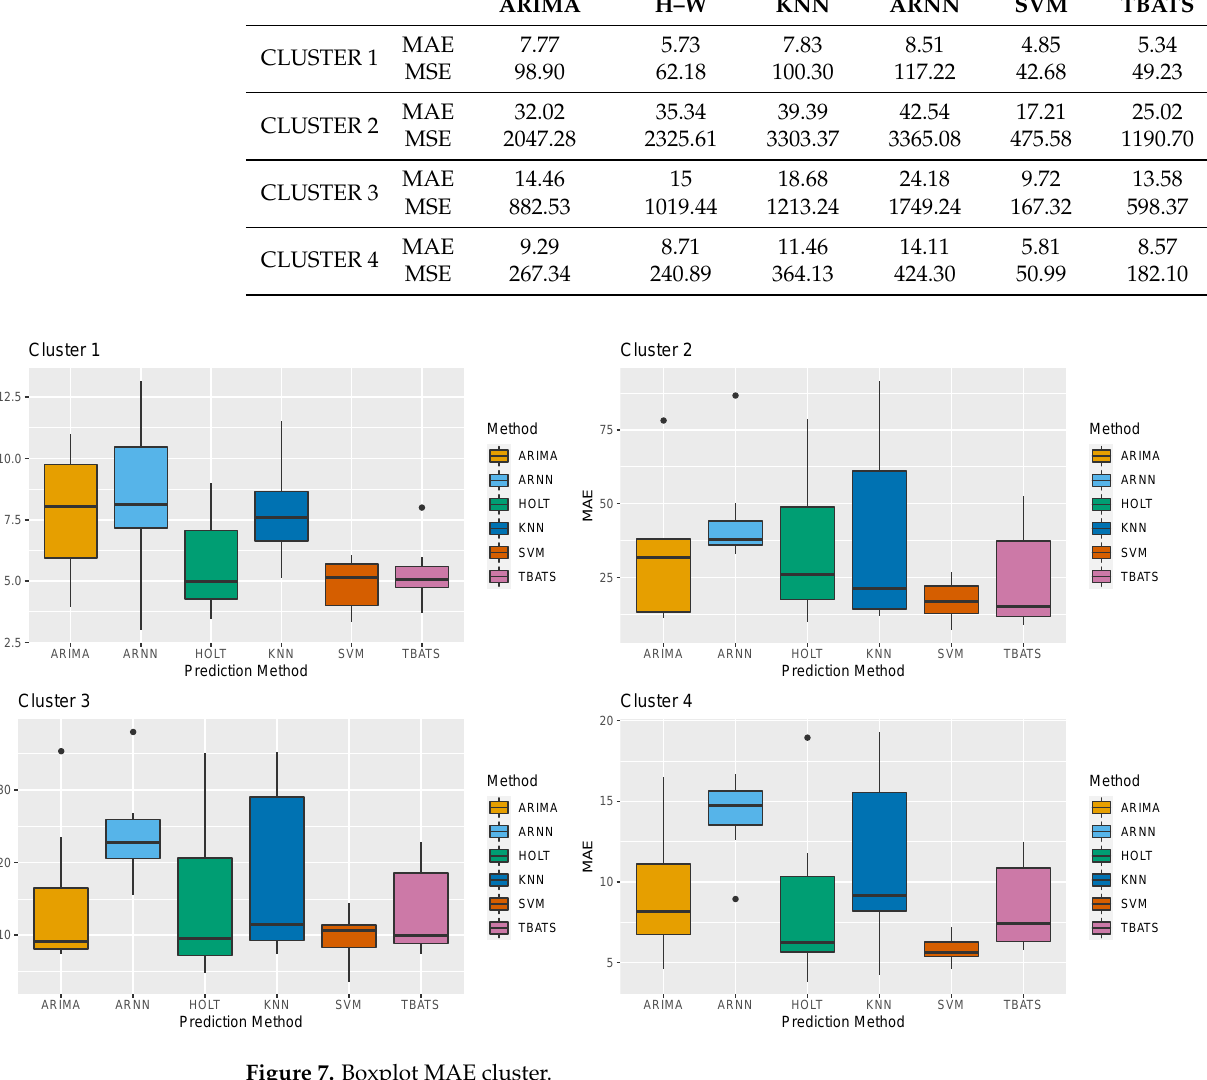
Figure 7. Boxplot MAE